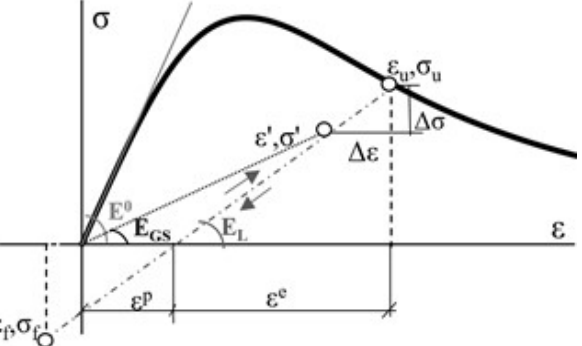
Figure 4. Linear unloading/reloading based on the focal